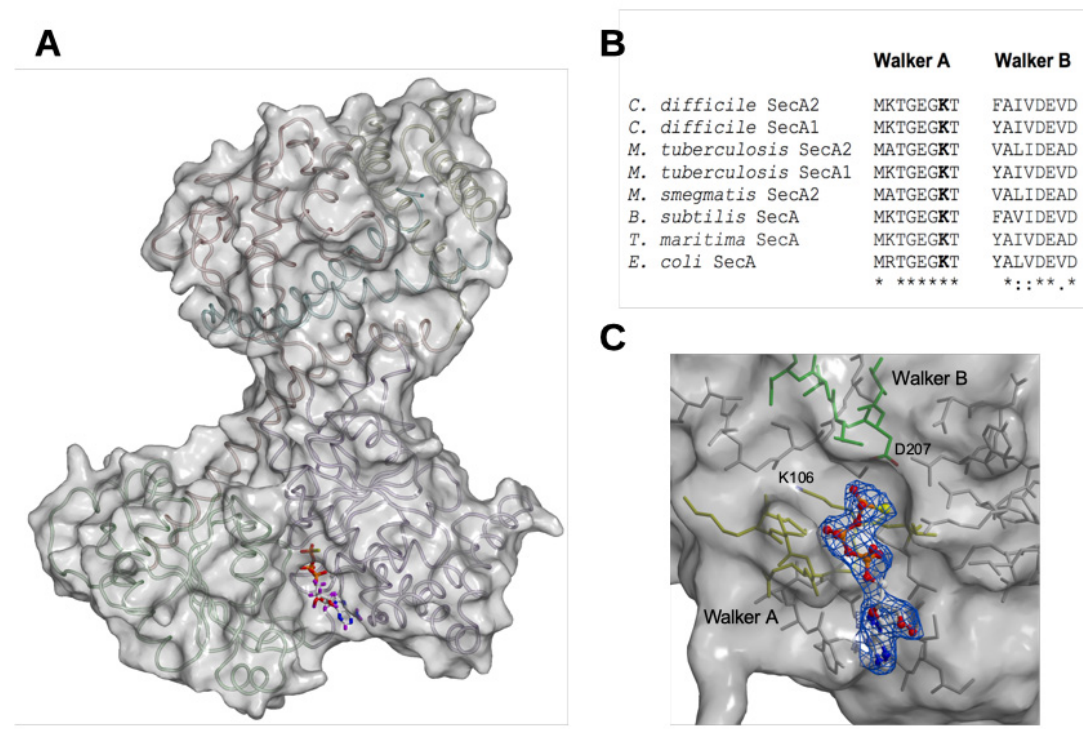
Figure 2. CDSecA2 ATP binding. ( A ) The structure of CDSecA2 (transparent surface with ribbons) in complex with ATP- γ -S (sticks). ( B ) The conservation of Walker motifs in the CDSecA1 and A2 proteins is shown in sequence alignment. Conserved residues of CDSecA2 involved in nucleotide and Mg binding and ATP hydrolysis are aligned with the corresponding residues of CDSecA1 and other SecA representatives from various bacterial species. ( C ) The CDSecA2 surface region that binds ATP- γ -S (stick and ball representation) in maximum-likelihood free kick weighted 2mFo-Dfc [38] is depicted. Walker A and Walker B motifs are shown as yellow and green sticks, respectively. Color code of ATP- γ -S: blue, nitrogen; red, oxygen; white, carbon; orange, phosphate; yellow, sulfur and purple, hydrogen.